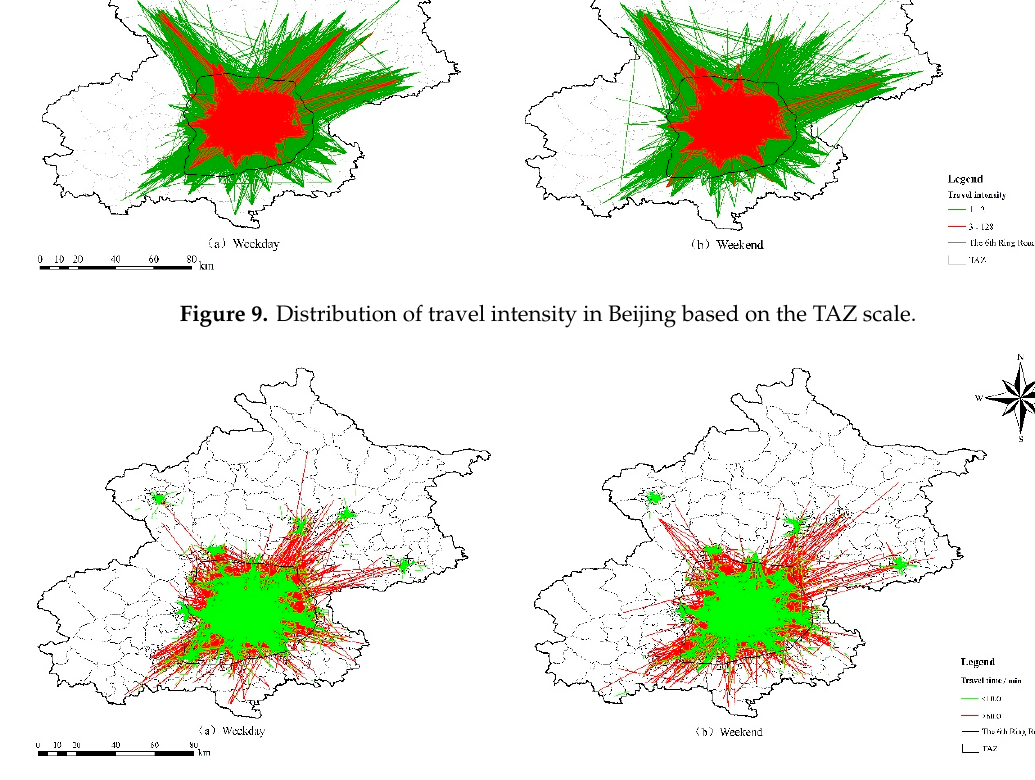
Figure 10. Distribution of travel time in Beijing based on the TAZ scale.